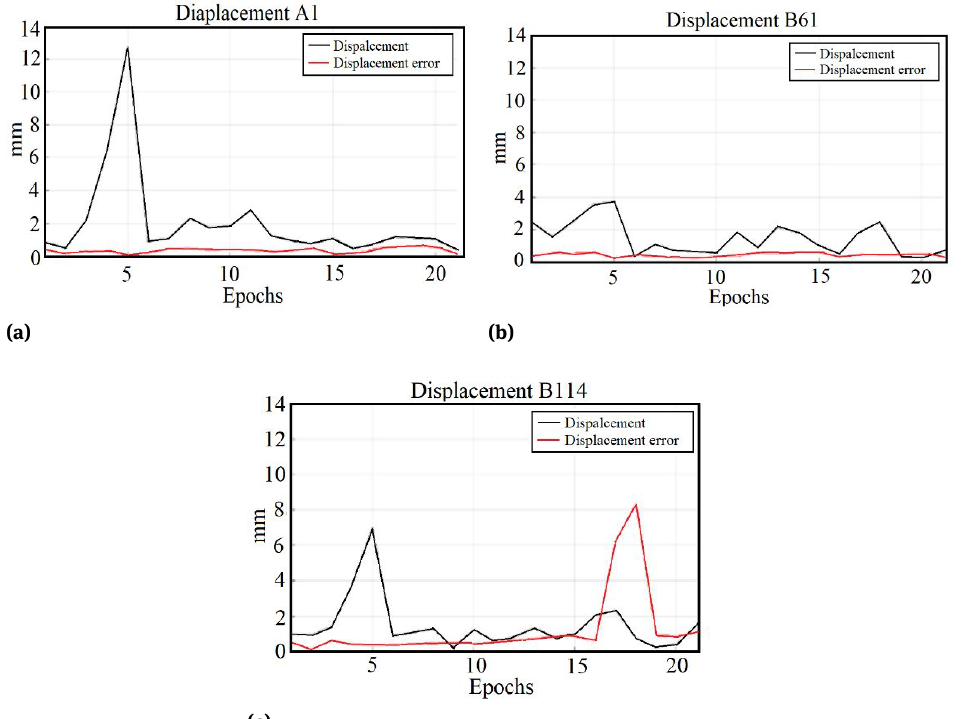
Figure 6: Plots of displacements and their errors for points a) A1, b) B161 and B114.